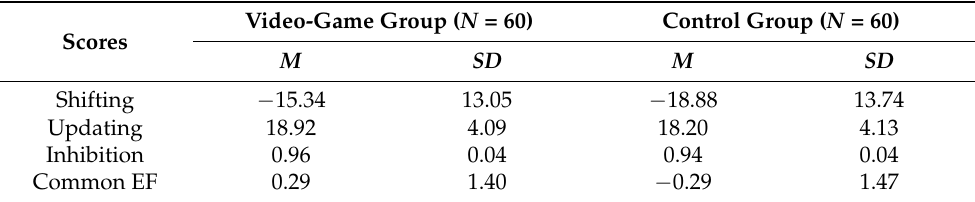
Table 2. Means and standard deviations for the scores of executive function.